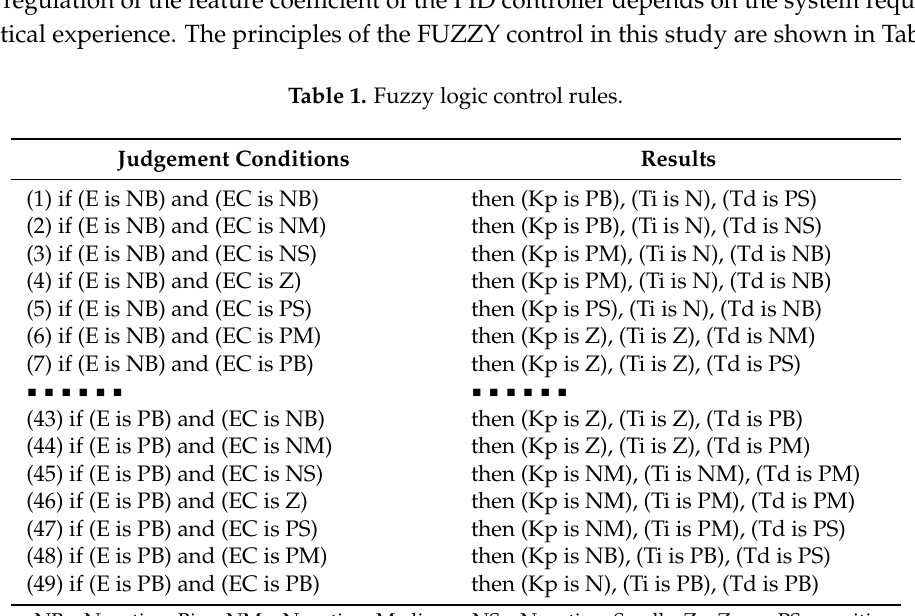
Figure 6. Structure of Fuzzy Control System.